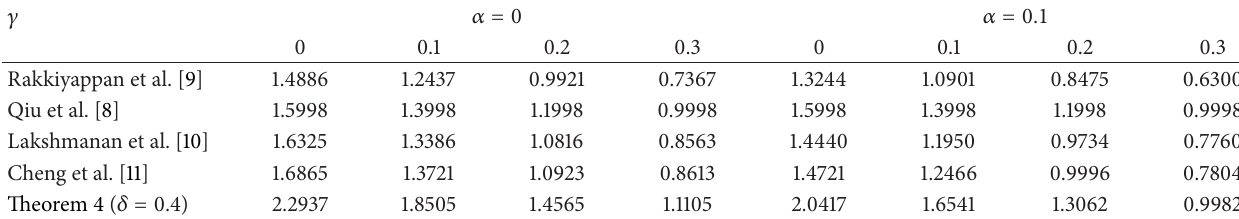
Table 1: Maximum upper bound of ℎ with ℎ 𝑑 = 0.5 and different values of 𝛾 .